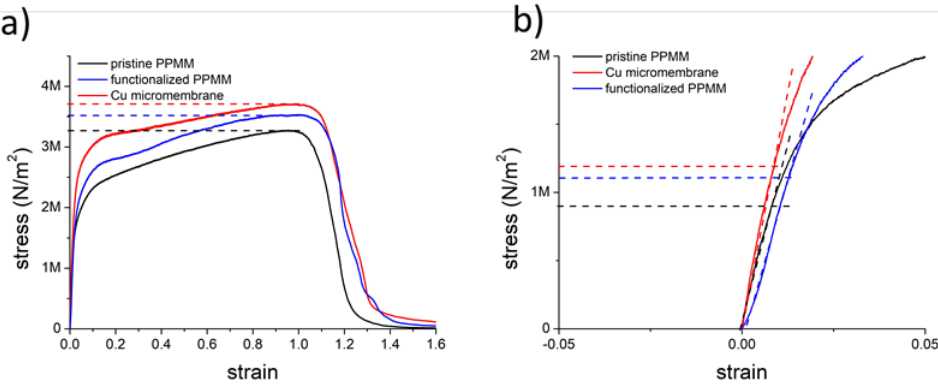
Figure 7. The stress–strain curve for pristine PPMM, functionalized PPMM, and Cu micromem- brane: ( a ) overall and ( b ) enlarged profiles near the yield point. ( a ) overall and ( b ) enlarged profiles near the yield